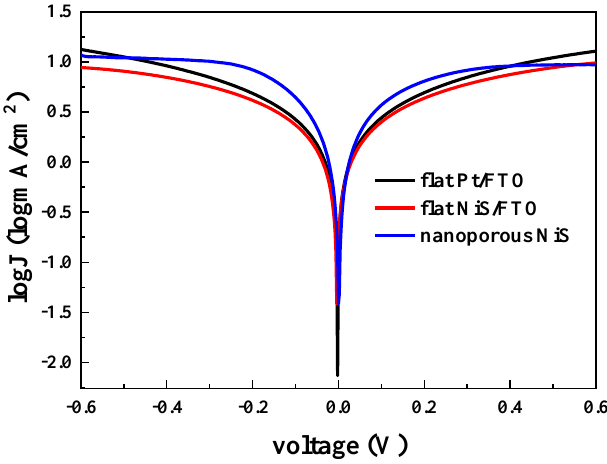
Figure 5. Tafel curves of nanoporous NiS, flat NiS / FTO, and flat Pt / FTO.